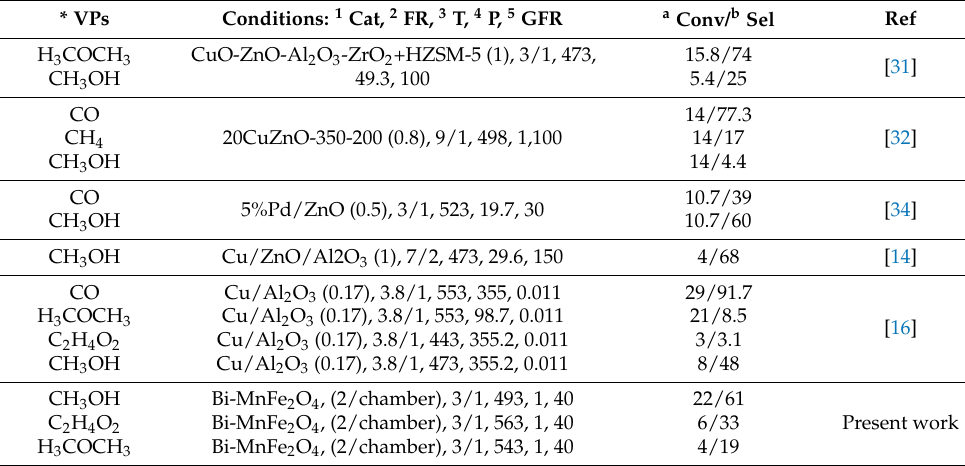
Table 2. Comparative study for valuable organic products under different reaction